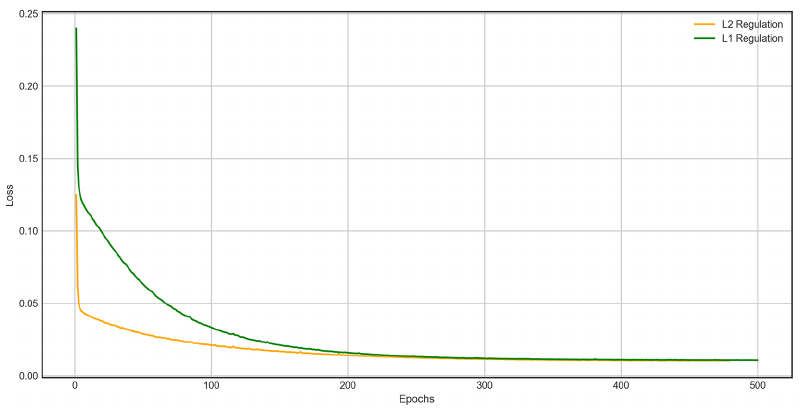
Figure 9. L1, L2 Regulation (Case 5 and 6).